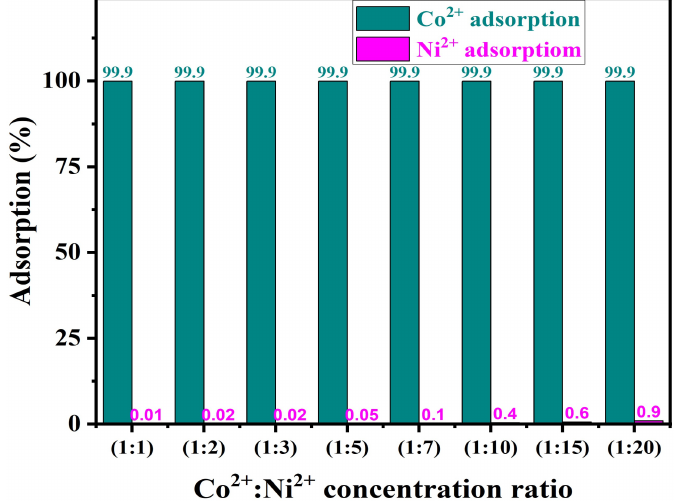
Figure 8. Influence of nickel concentration upon the selectivity of PTU-MSA for Co 2+